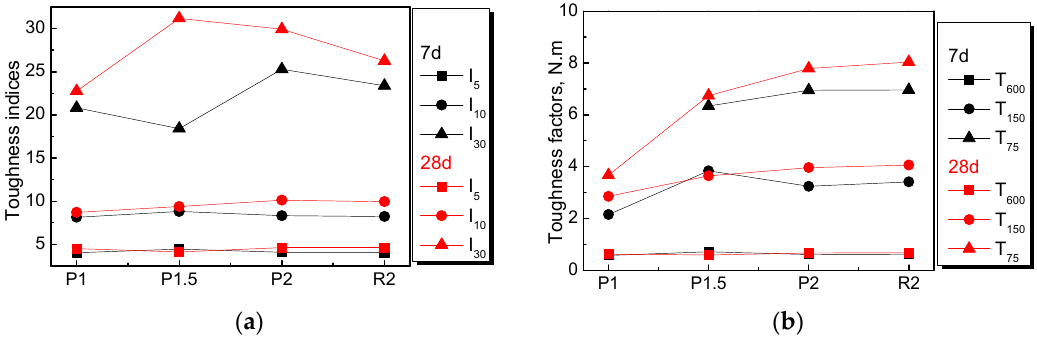
Figure 12. Flexural toughness parameters: ( a ) toughness indices and ( b ) toughness factors of NPFRCCs at seven days and 28 days.